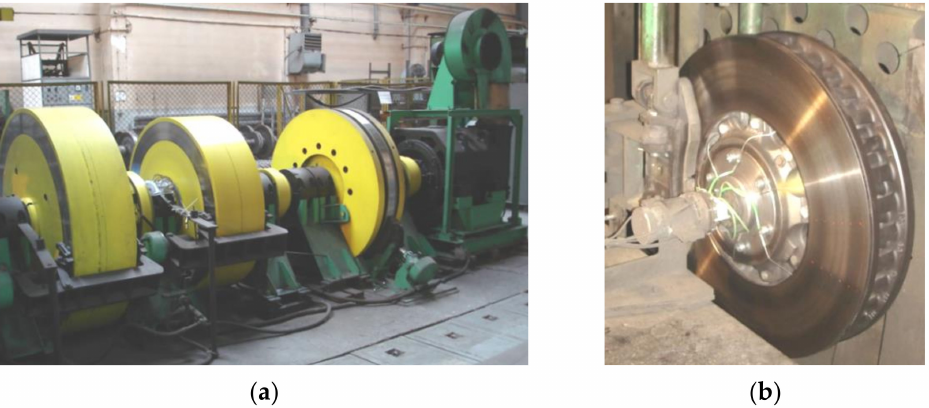
Figure 1. Brake bench for testing railway disc brakes: ( a ) drive part of the brake stand with rotating masses, ( b ) brake disc type 610 × 110 mounted on a brake